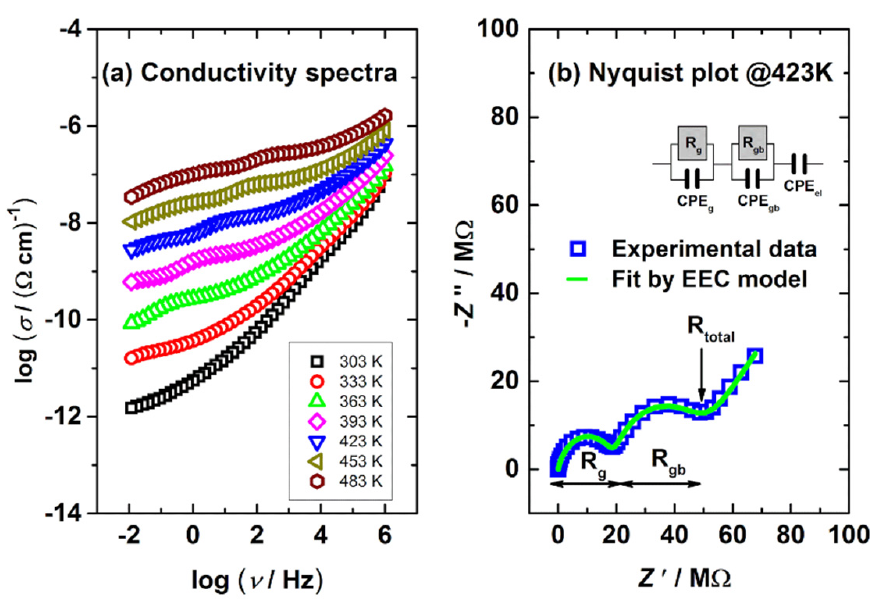
Figure 4. ( a ) Conductivity spectra and ( b ) Nyquist plot obtained at 423 K for the control sample ZR. EEC for the complex data fitting is shown in the ( b ) inset.